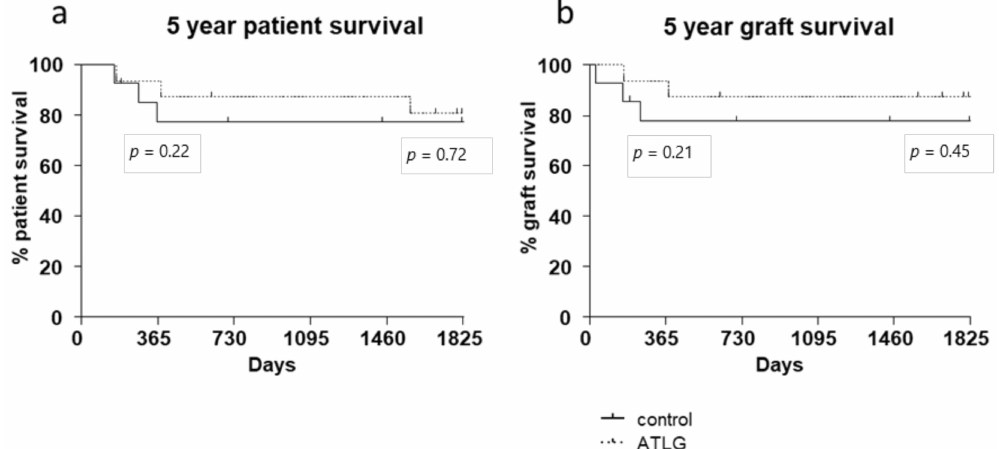
Figure 4. Patient and graft survival. No differences in ( a ) patient and ( b ) graft survival were detected between ATLG- perfused livers and control-perfused livers. The displayed p-values indicate 1- and 5-year survival. (AP: 93% 1-year patient survival vs. CP: 77% 1-year patient survival, p = 0.220; AP: 80% 5-year patient survival vs. CP: 77% 5-year patient survival, p =